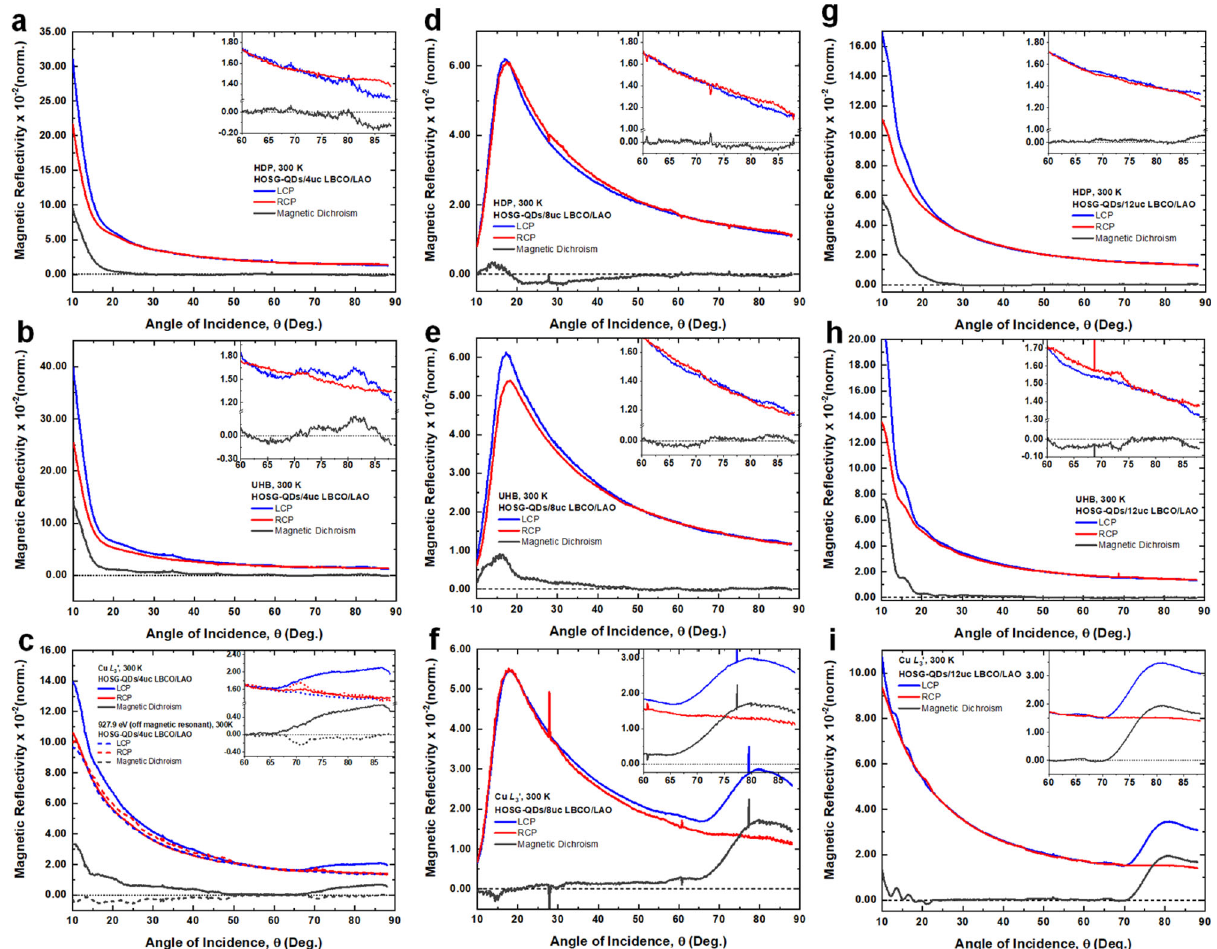
Fig. 3 Room temperature resonant soft X-ray and magnetic scattering (RSXMS). RSXMS at room temperature: for HOSG-QDs/4uc LBCO/LAO at a HDP, b UHB, and c Cu L 3 ’ and 927.9 eV (off-resonance); for HOSG-QDs/8uc LBCO/LAO at d HDP, e UHB, and f Cu L 3 ’ ; and for HOSG-QDs/12uc LBCO/ LAO at g HDP, h UHB, and i Cu L 3 ’ . Insets show the magni fi ed data at higher incident